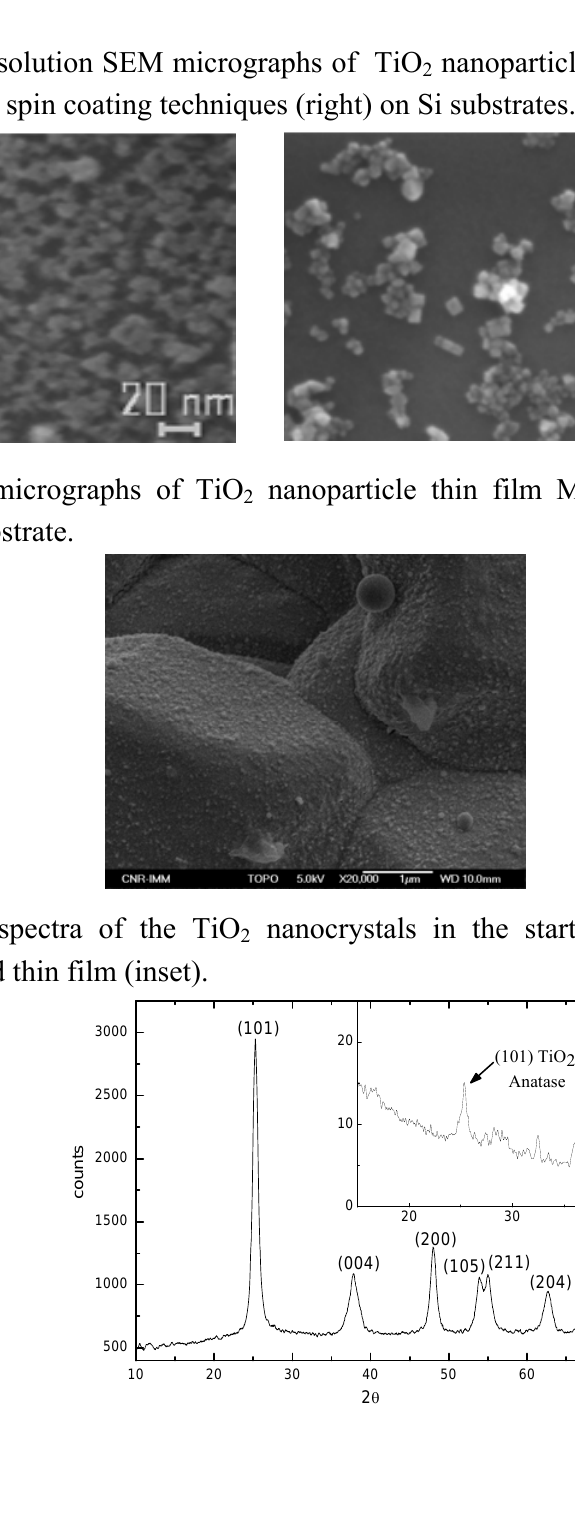
nanoparticle thin films deposited by 2